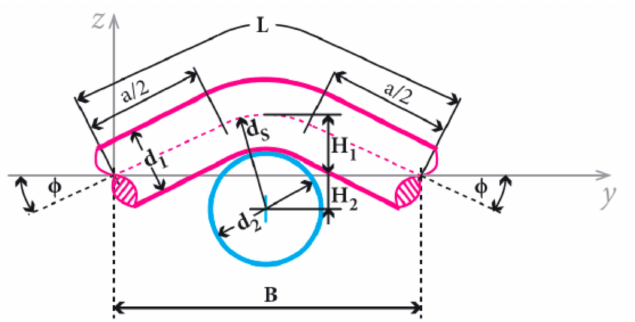
Figure 1. Peirce’s geometrical model of the interlacing point [22]. Legend: a is the length of the line connecting the arcs, d 1 is the diameter of the warp, d 2 is the diameter of the weft, d s is the sum of radii of the warp and weft yarns, H 1 is the height of warp interlacing wave, H 2 is the height of weft interlacing wave, B is the spacing of weft yarns, Φ is the warp interlacing angle, and L is the length of warp